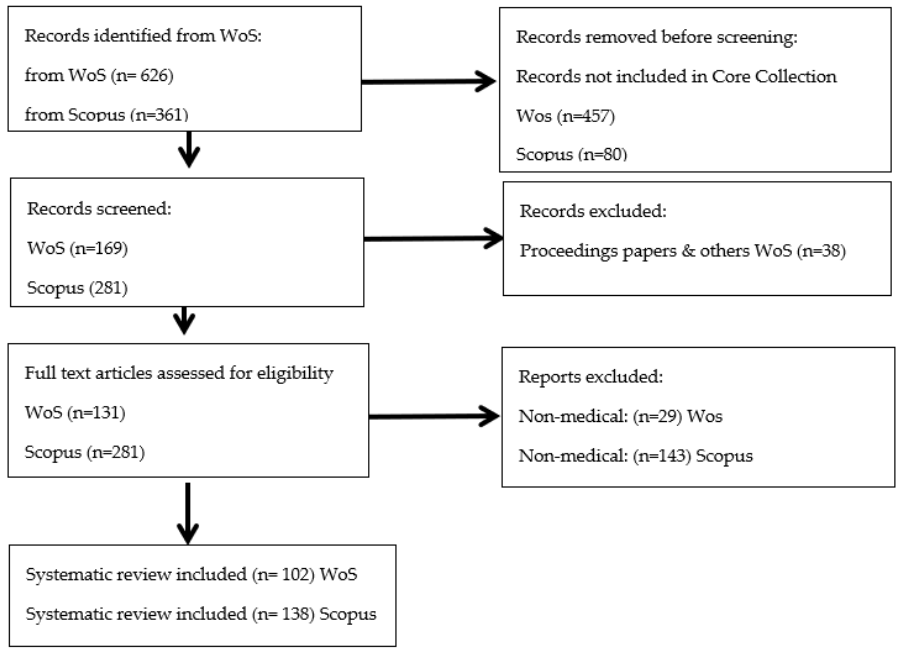
Figure 1. Flow diagram of systematic review (adapted from the Preferred Reporting Items for Systematic Reviews (PRISMA 2020) statement [108]).